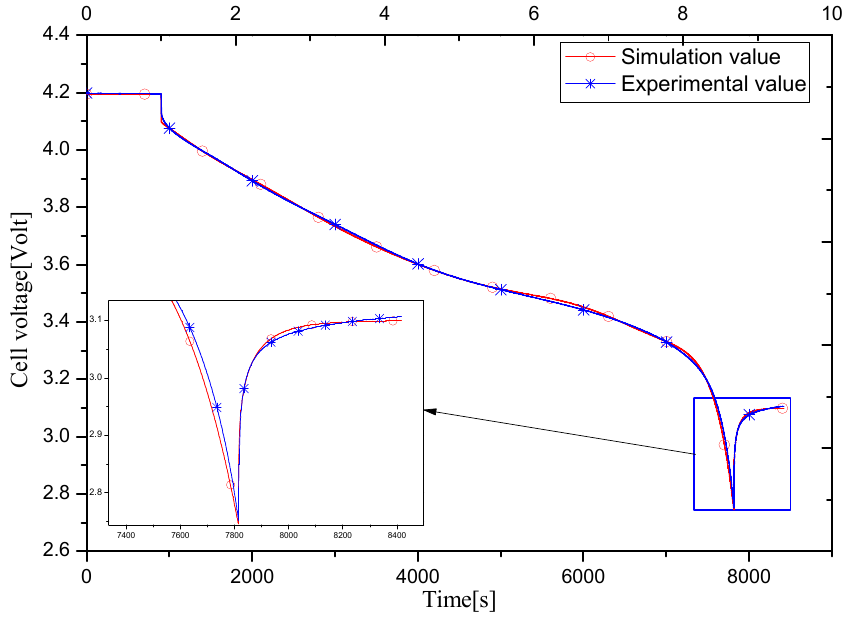
Figure 8. Comparison of experiment and simulation results of 0.5 C discharge.